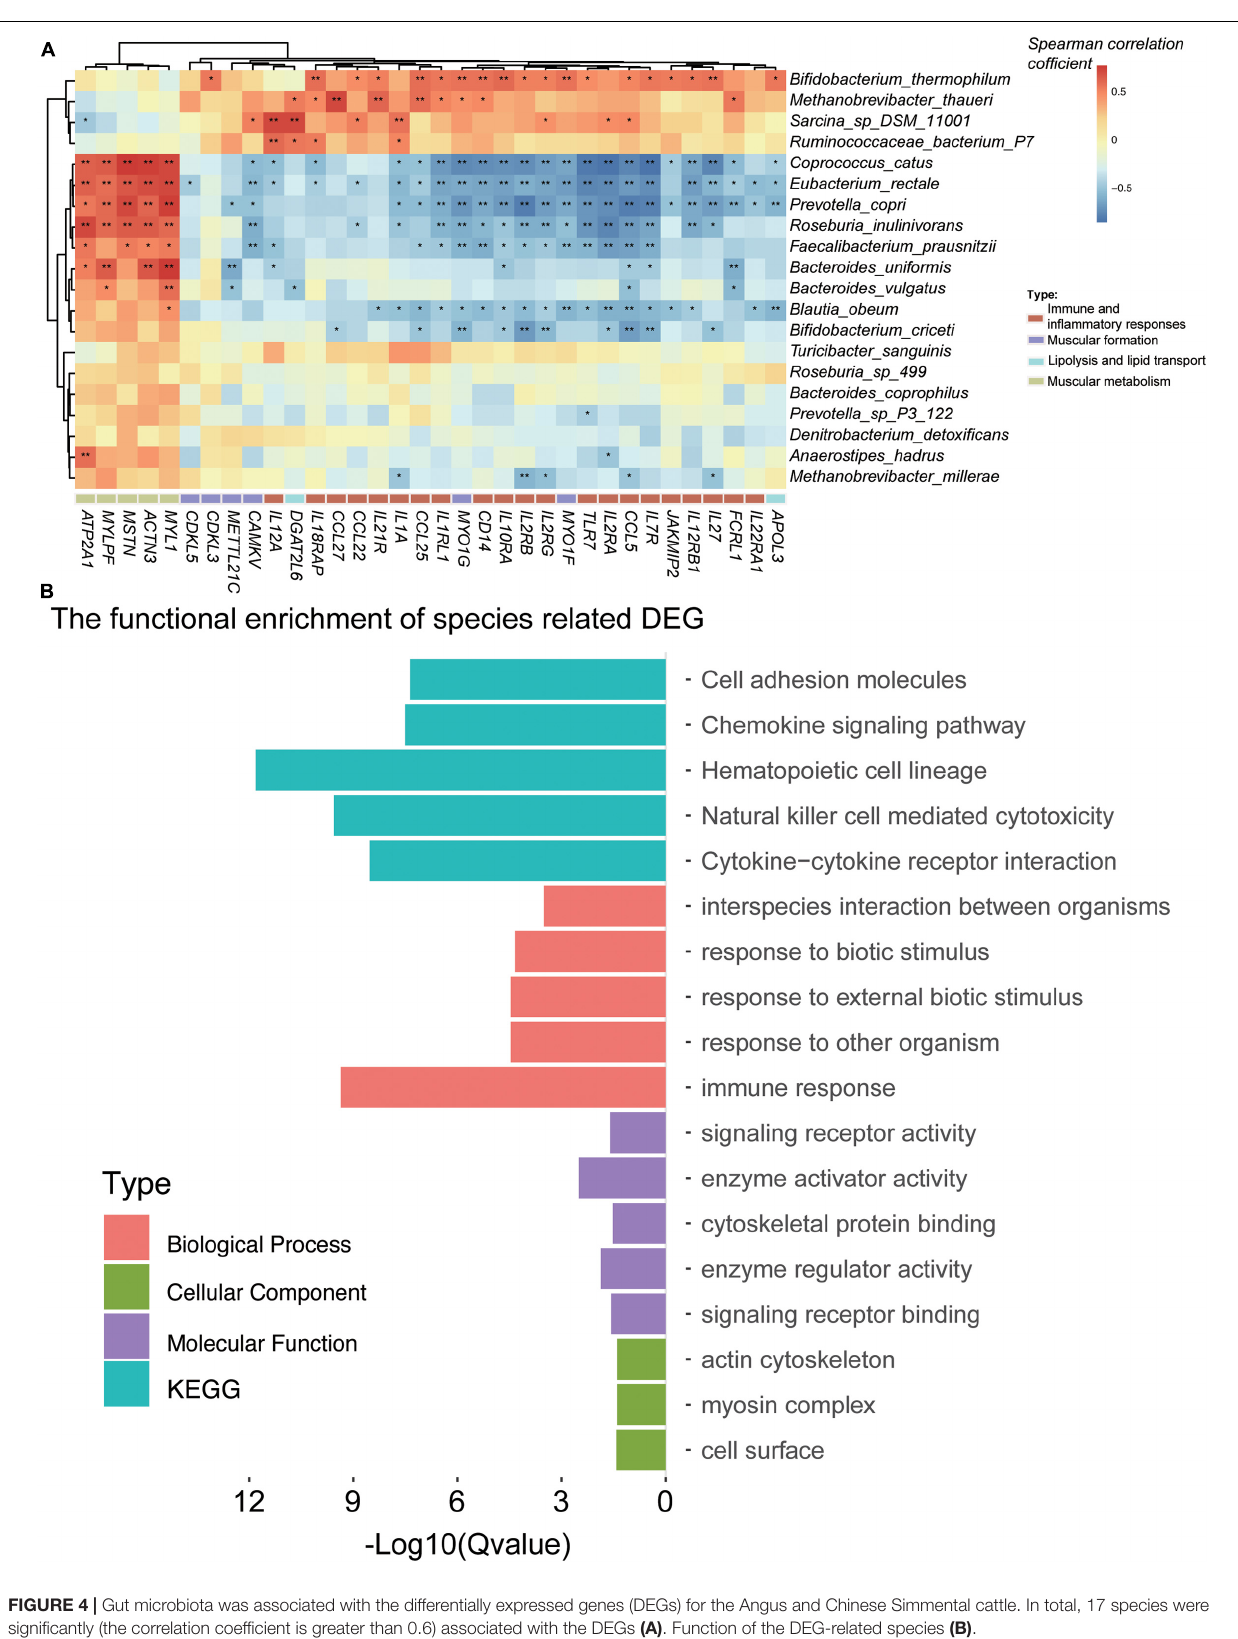
Frontiers in Microbiology |